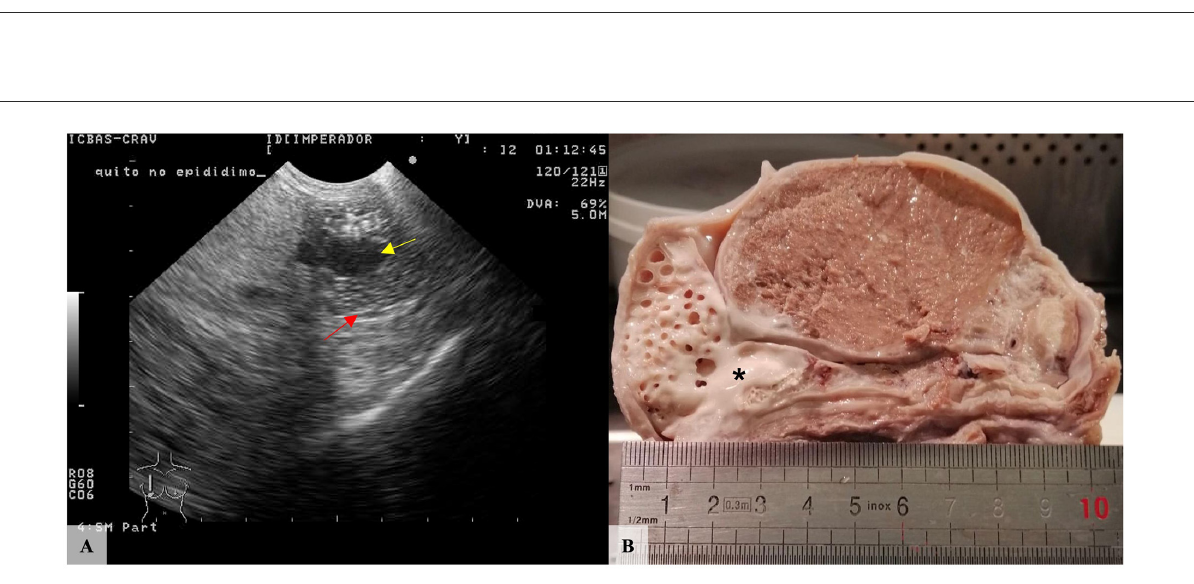
FIGURE2 Purebred Lusitano stallion, right testis. (A) Ultrasound showed a well-circumscribed anechoic cystic structure (yellow arrow) in the epididymis. Red arrow: Epididymal wall. (B) Macroscopically, the largest cystic lesion ( * ) is filled with whitish and semen-like material located in the terminal portion of the body of the epididymis. Several smaller cavities were also identified in the tail of the